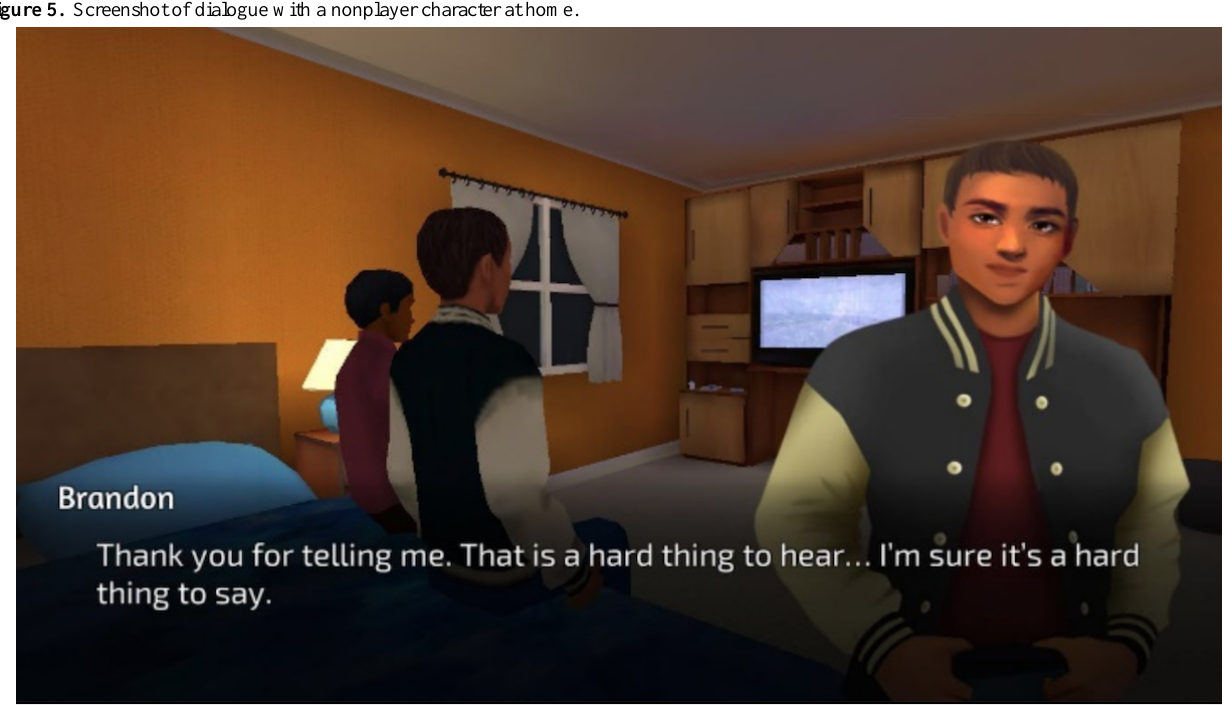
Figure 5. Screenshot of dialogue with a nonplayer character at